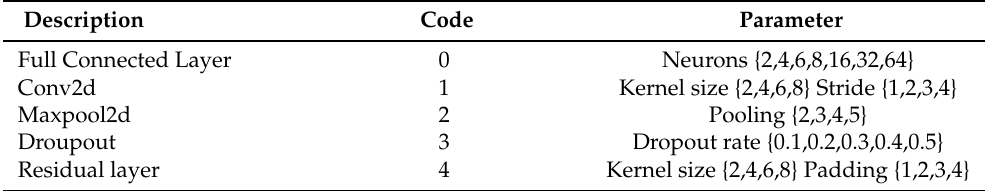
Table 2. Model Architecture Coding Method.